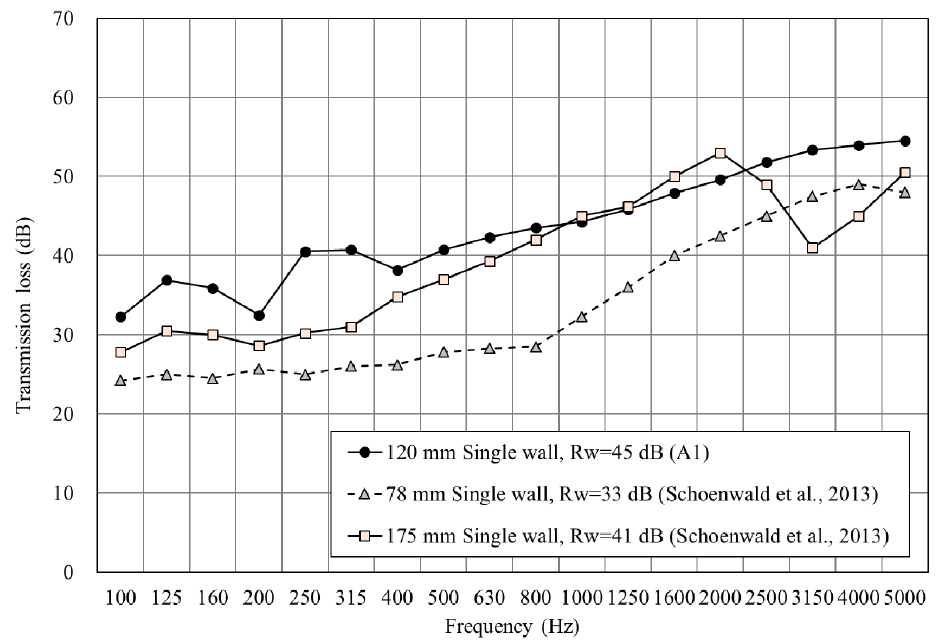
Figure 6. The sound insulation performance of the single wall.